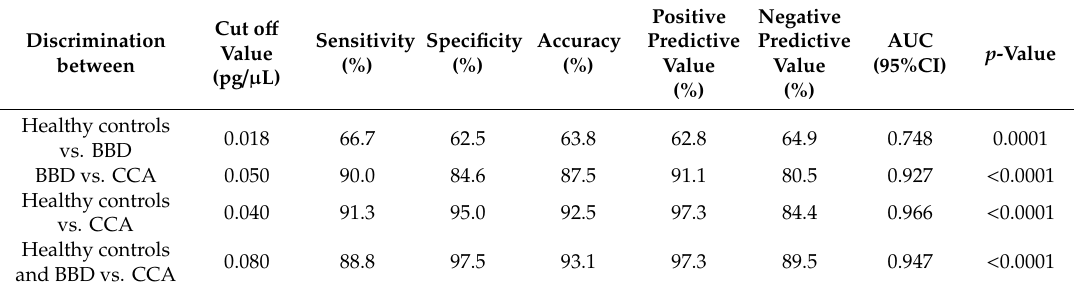
Table 2. The overview of ROC curve evaluation of APEX1 as a diagnostic marker for CCA. Discrimination between Healthy controls vs. BBD Healthy controls vs. CCA